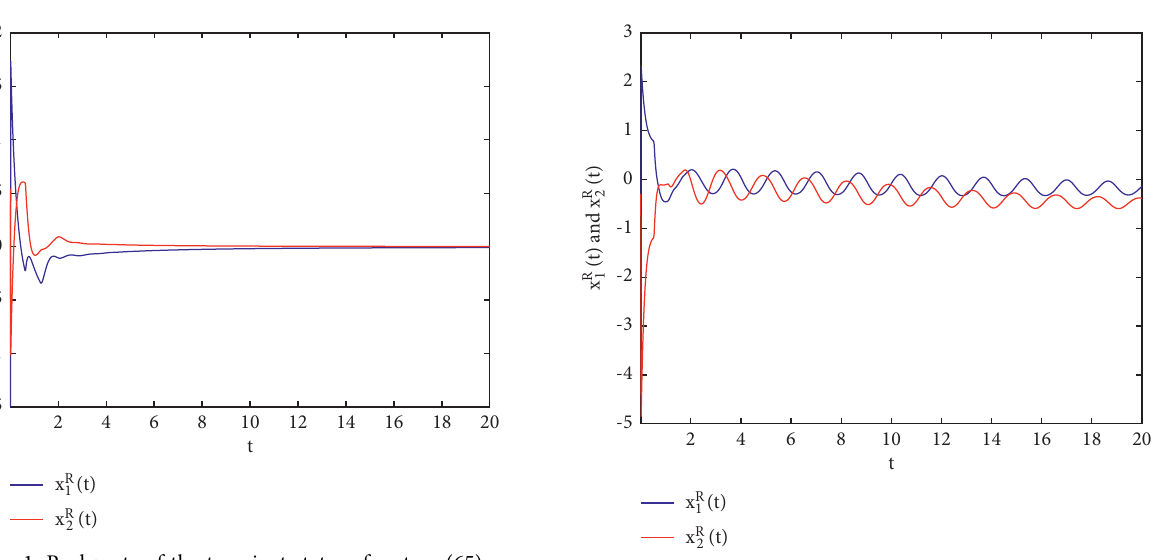
Figure 3: Real parts of the transient states of system (68) without